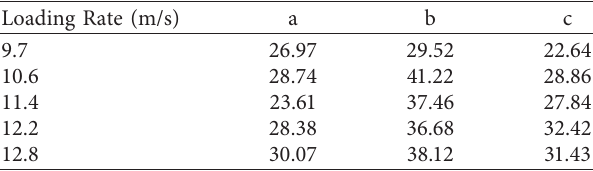
Table 9: Crack initiation stress in MPa.